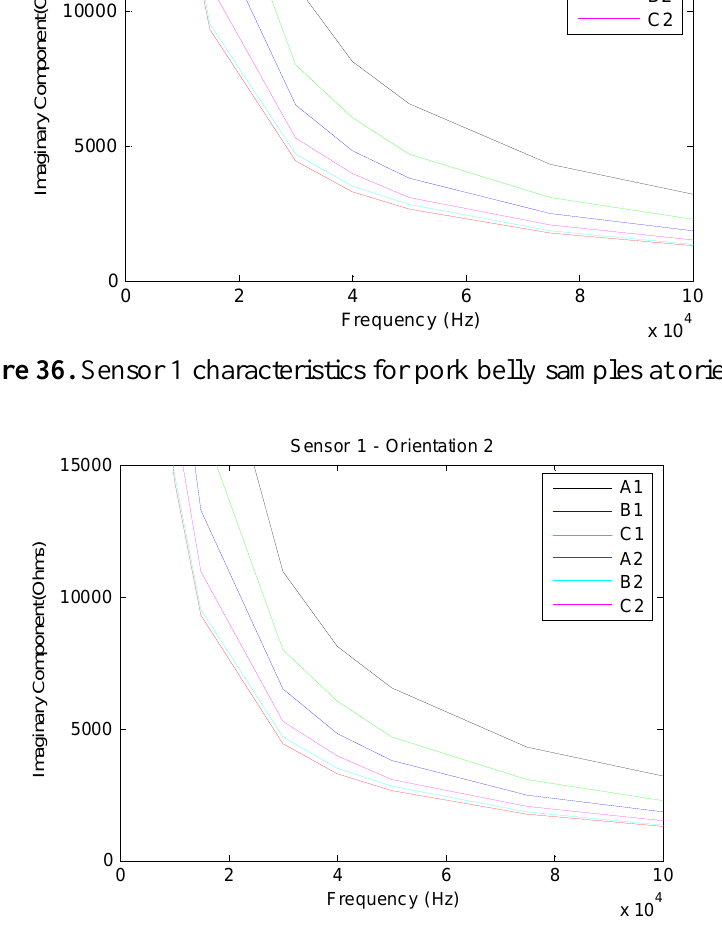
Figure 37. Sensor 1 characteristics for pork belly samples at orientation